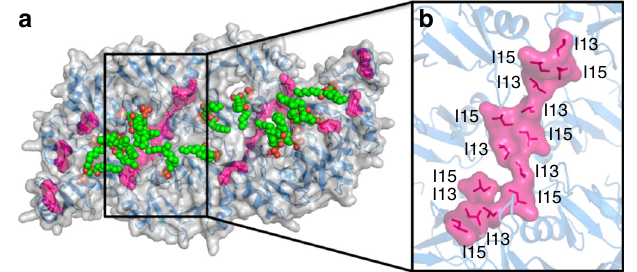
Fig. 5 The arc – arc interactions in the membrane disruption complex are mediated via an isoleucine zipper. a The 20-meric complex (blue cartoon representation with gray transparent surface rendering) in the asymmetric unit with its 14 bound PA molecules (spheres with carbon in green, oxygen in red, phosphorus in orange). The residues Ile13 and Ile15 are highlighted in pink in the interfaces between constituent arcs that comprise the 20-meric NaD1 – PA complex. b A close-up view of one of the isoleucine zippers between two arcs in the 20-meric complex. The seven pairs of isoleucines form a continuous hydrophobic interface between the two arcs as shown by the surface representation in